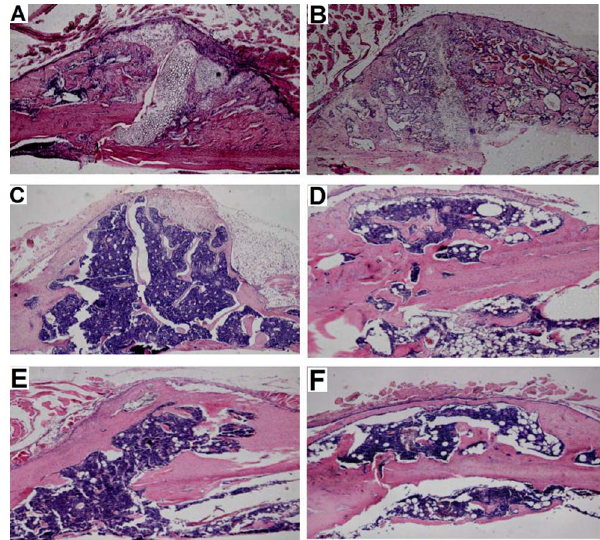
Figure 2. Longitudinal sections of the callus of femora at 2 (A and B), 5 (C and D) and 10 (E and F) weeks post-fracture. A, C and E show the callus of vehicle treated controls, B, D and F that of telmisartan-treated